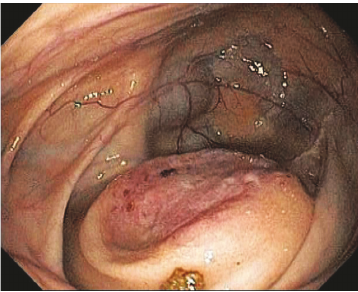
Figure 44: Endoscopic image of a secondary appendiceal cancer from a primary lung